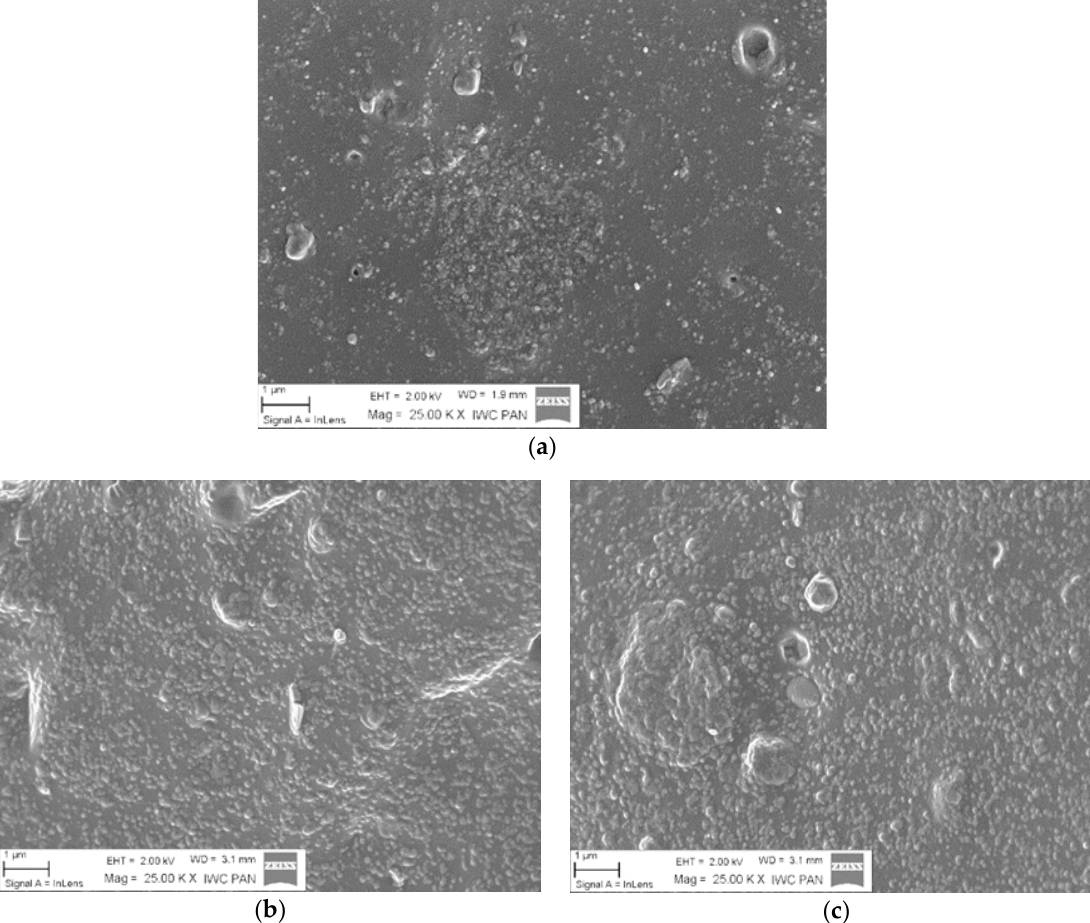
Figure 4. Scanning electron microscopy (SEM) micrographs of NBR / SiO 2 ( a ), NBR / SiO 2 / 5BMIMAlCl 4 ( b ), and NBR / SiO 2 / 5BMIMTFSI ( c ).